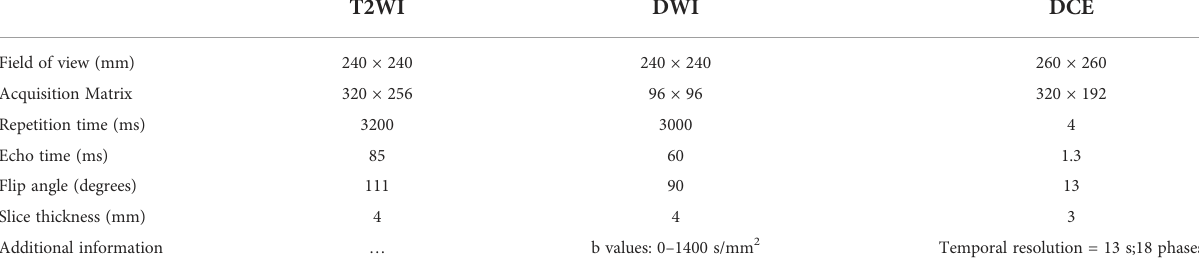
TABLE 2 The main sequence parameters in this study.